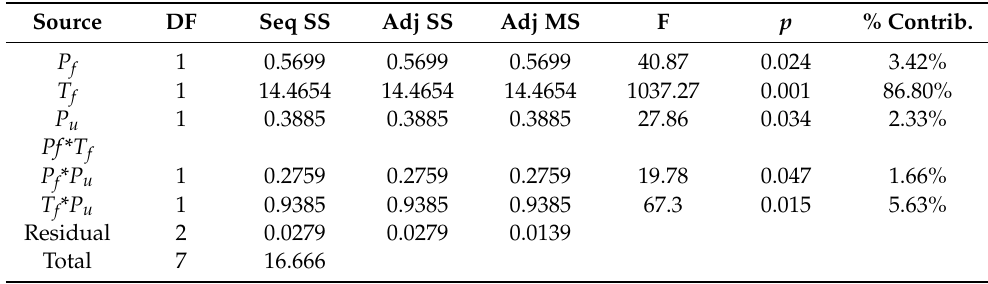
Table 9. Low-carbon steel–304 SS ANOVA analysis for the signal-to-noise ratio (the larger the better).